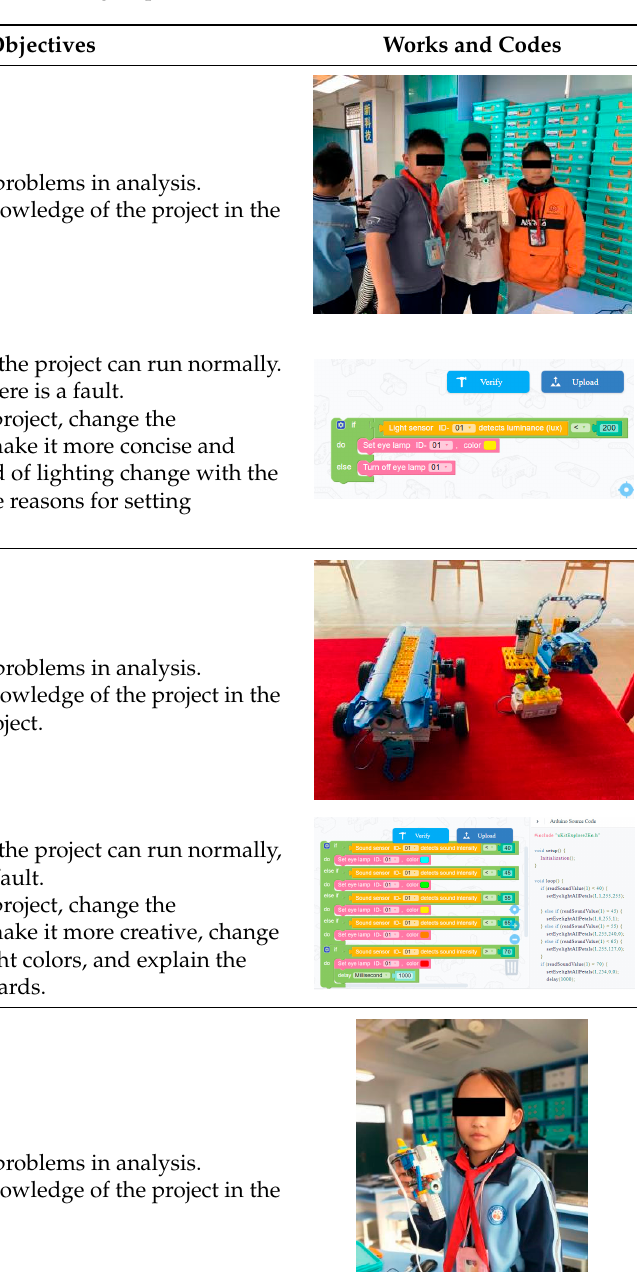
Table A2. Information on the experimental group’s six